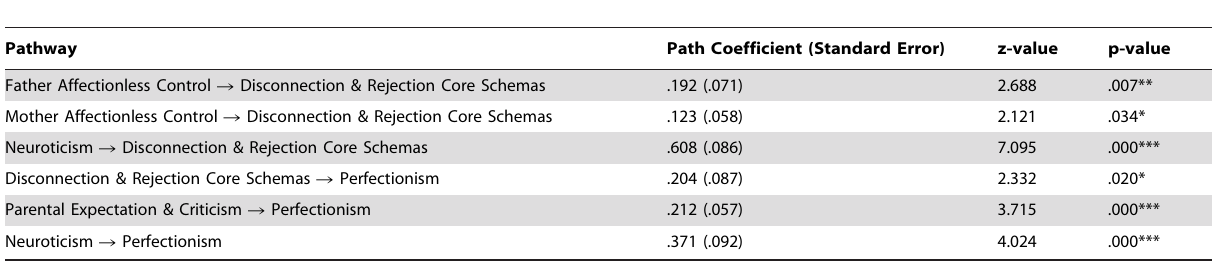
Table 5. Path Coefficients for the Six-Pathway Structural Model.